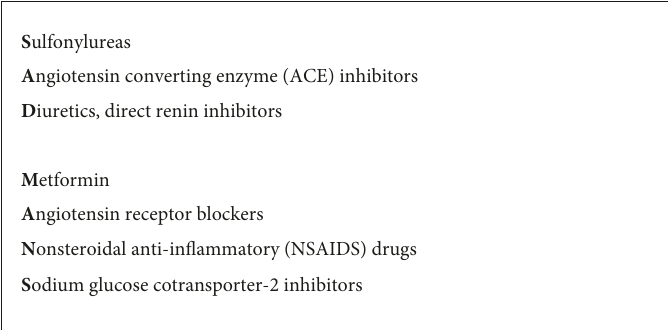
Figure 2: Sick day medication list. Figure adapted from Diabetes Canada